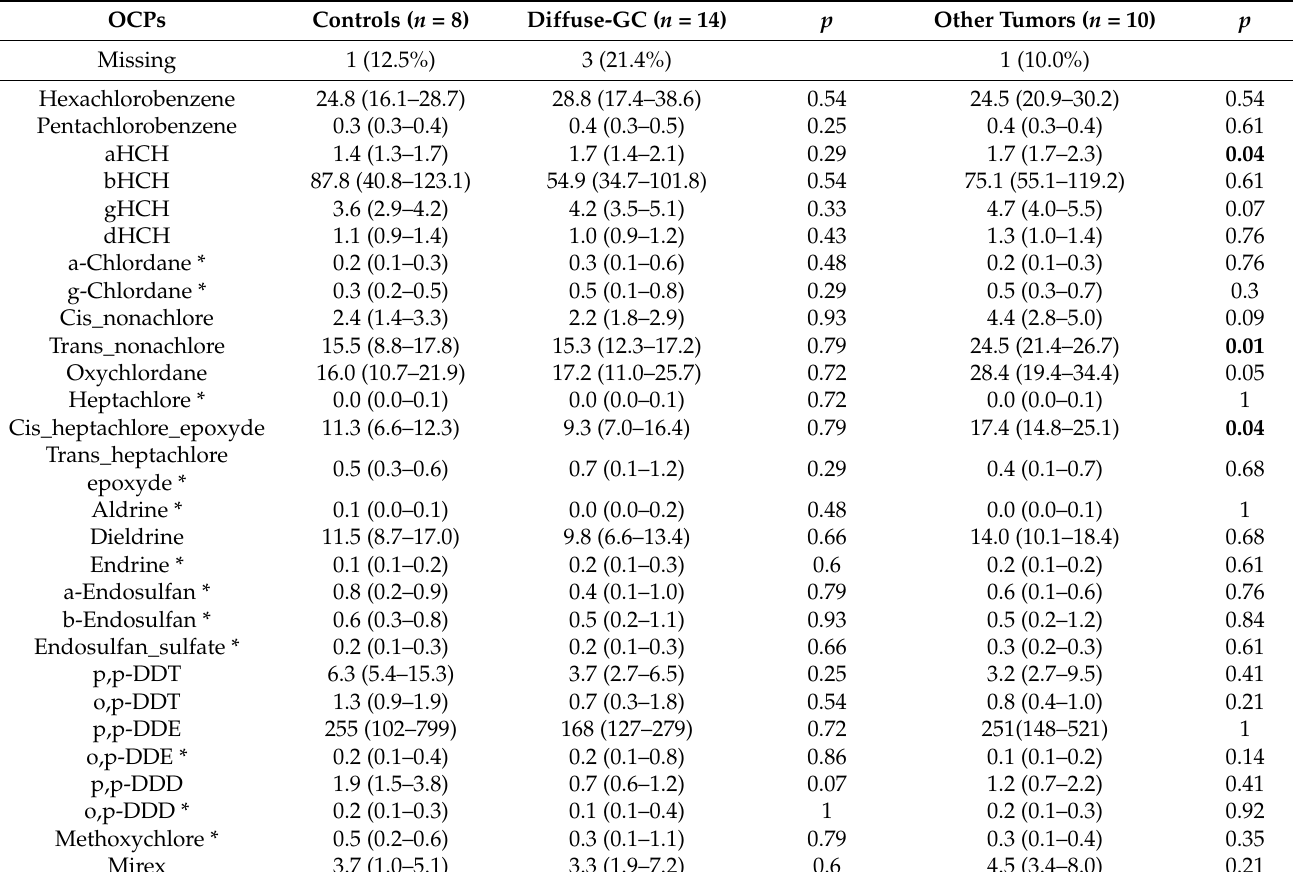
Table 5. Summary of organochlorinated pesticides (OCPs)distributions and detection frequencies (DF) measured in omental fat from cases of diffuse-gastric cancer, other cancers with peritoneal metastasis, and non-cancer as control patients. Results were represented by median (interquartile range) (ng/g lipid). The case groups were compared to the control group using Mann–Whitney U test ( p <